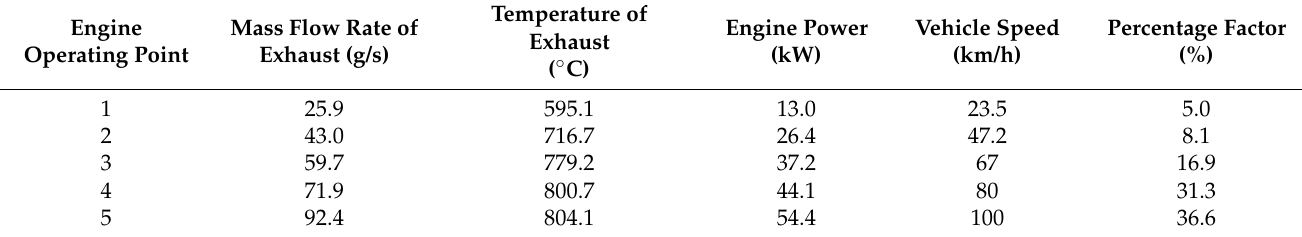
Table 3. Exhaust conditions and percentage factors at five major engine operating